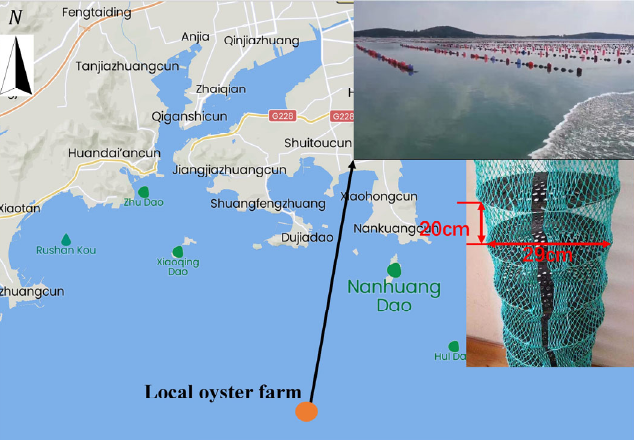
Figure 1. Location and image of the investigated longline aquaculture farm with lantern nets at a distance of 6.4 km from Nanhuang Island, Shandong Province, China, and the prototype of the lantern net with eight porous disks (material: rubber) with a diameter of 29 cm.